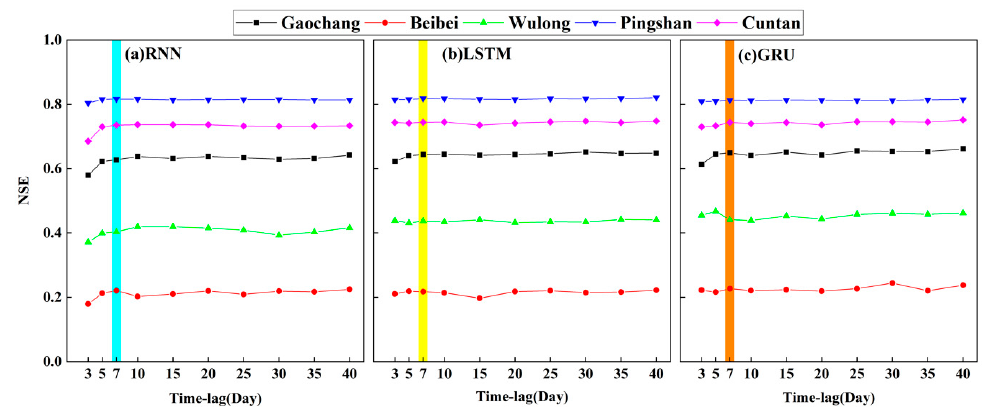
Figure 5. NSE value of ( a ) RNN, ( b ) LSTM, and ( c ) GRU with different time lags (3, 5, 7, 10, 15, 20, 25, 30, 35, and 40 days) at daily prediction. Table 3. The optimal time-lag settings at daily prediction.